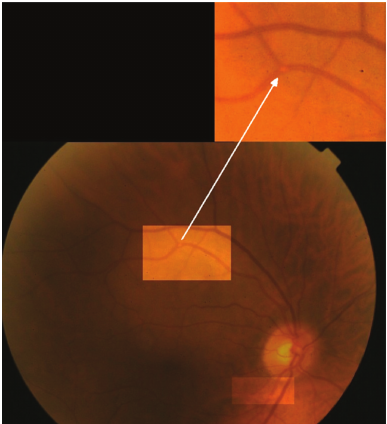
Figure 1: Right eye fundus photography of the patient: see the two emboli along the inferotemporal (highlighted area) and superotem- poral (highlighted and magnified area)